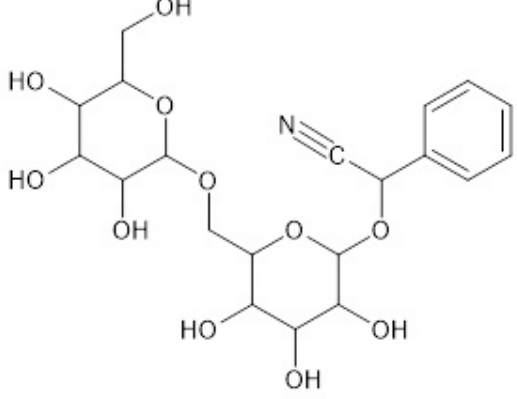
Figure 1. Molecular structure of amygdalin .